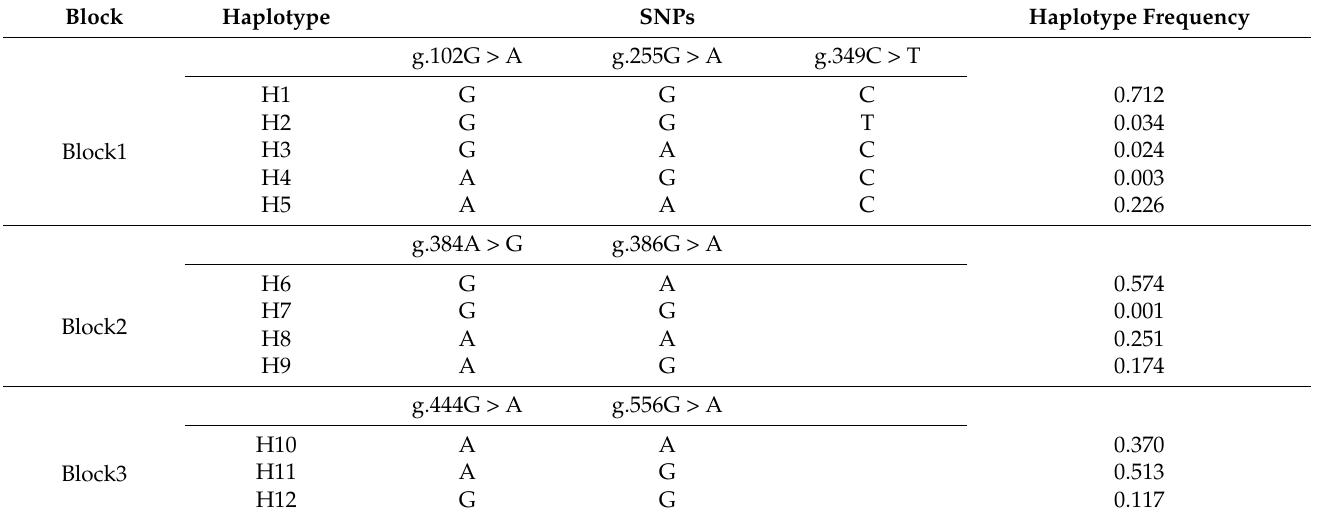
Table 5. Haplotype composition of the three linkage regions.